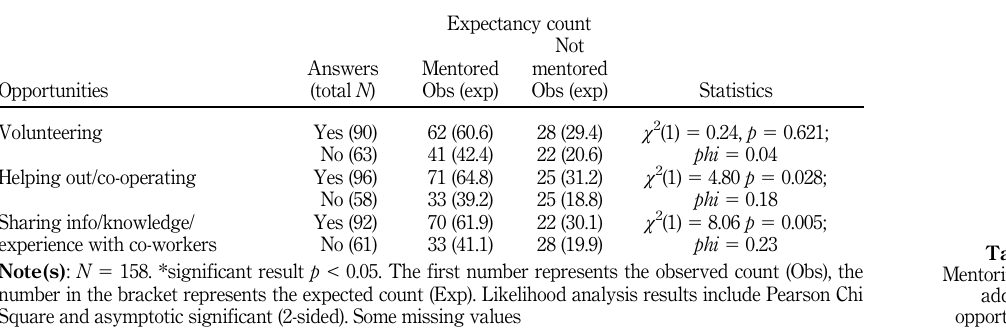
Table 3. Mentoring and